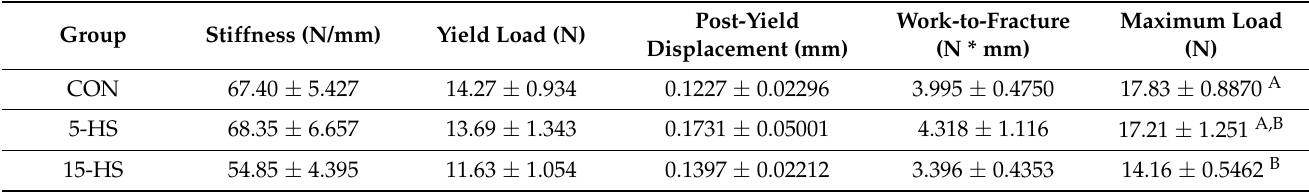
Table 4. Extrinsic mechanical properties of the right femur by diet group *.